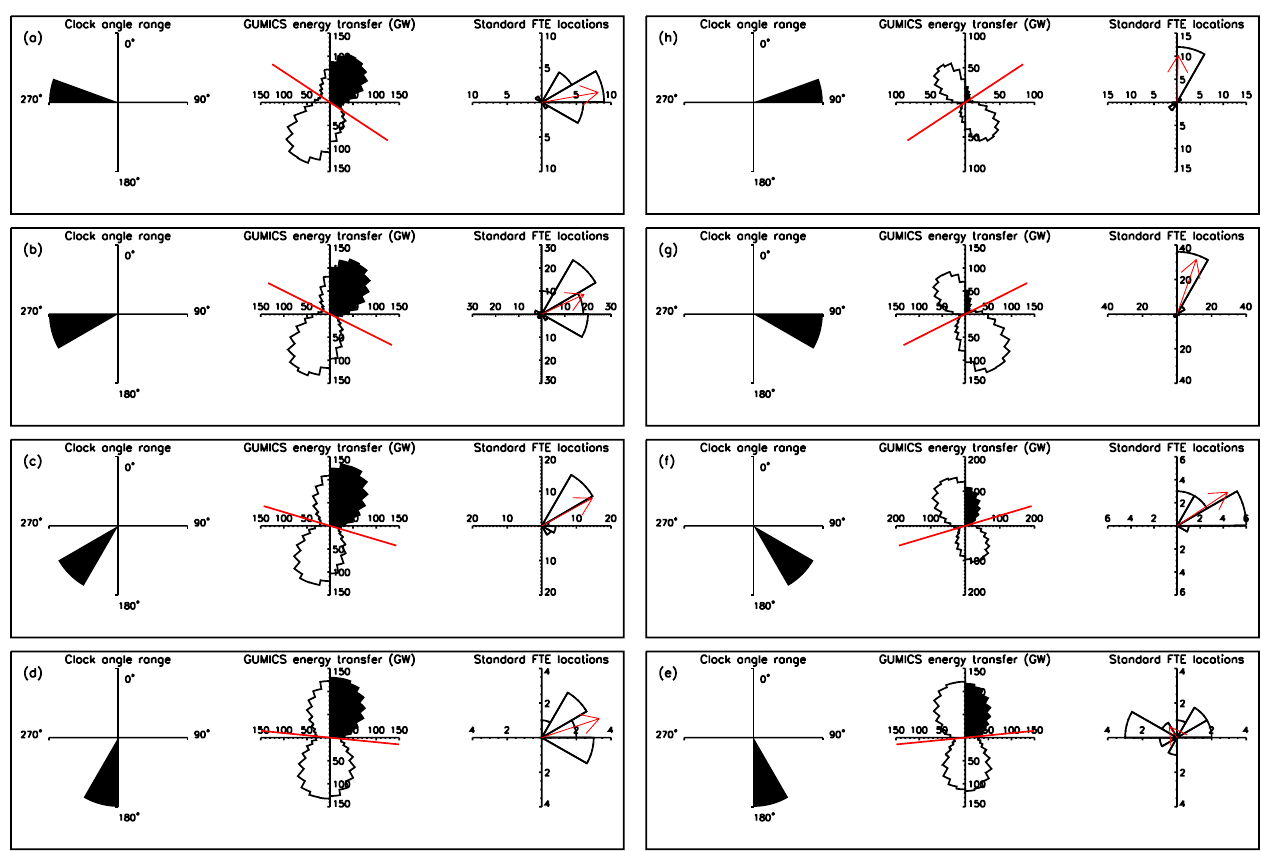
Fig. 5. Comparison of the FTE locations against the GUMICS-4 energy transfer as a function of IMF clock angle. In each panel, the leftmost diagram shows the clock angle range for which the two other diagrams are plotted. The center diagram shows the average energy transfer distribution which occurs in the GUMICS-4 model during the events listed in Table 1, projected onto the GSM yz plane. The red line is a component reconnection line calculated using Eq. (1) of Gonzalez and Mozer (1974) (assuming geomagnetic and magnetosheath magnetic field strengths of 50nT and 30nT, respectively). The shaded part of the center distribution corresponds to the part of the magnetopause which Cluster observes northward of the X-line during the Northern Hemisphere winter. The rightmost diagram is a polar histogram of the standard polarity FTE locations with the red arrow indicating the average direction of motion (Fear et al., 2012). Note that the scales in each diagram are not the